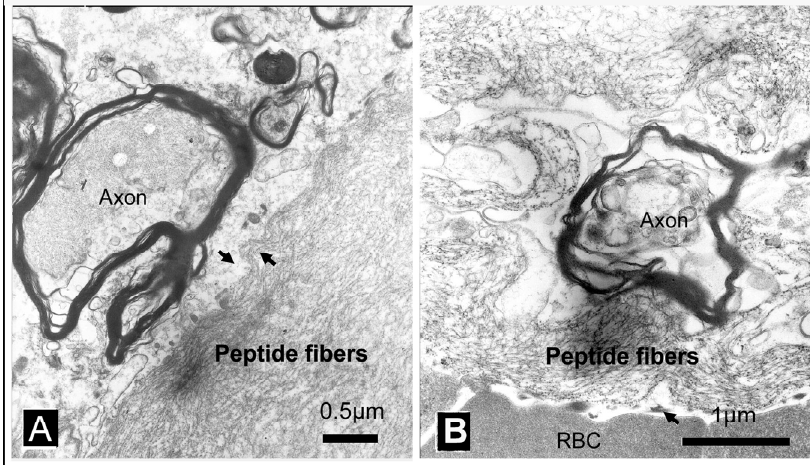
Figure 7. Transmission electron microscopy (TEM) images showing the RADA16-1 nanofibers and interactions between RADA16-1 with tissues: ( A ) The cut in the spinal cord was treated with RADA16-1. Note the tight interactions between the irregular interfaces (black arrow). ( B ) A tiny vacant space presented between red blood cells (RBCs) and RADA16-1 nanofiber scaffolds at the interface (black arrow). Scale bar represents A = 0.5 μ m, B = 1 μ